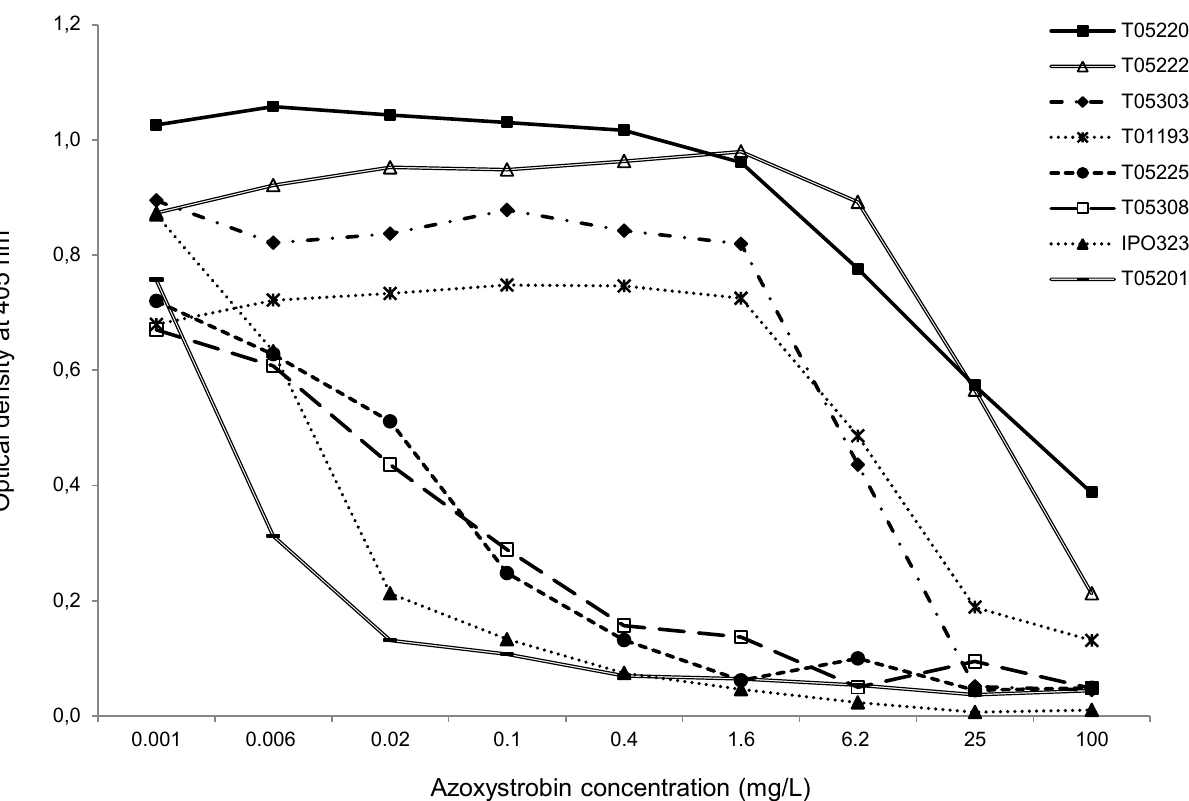
Figure 3. Dose-response curves of six Algerian Zymoseptoria tritici isolates and two reference isolates from Europe (IPO323: sensitive; T01193: resistant) obtained with azoxystrobin using a microplate bioassay. T05201, T05225, T05308 are sensitive isolates carrying the G143 allele and T05220, T05222, T05303 are resistant isolates carrying the A143